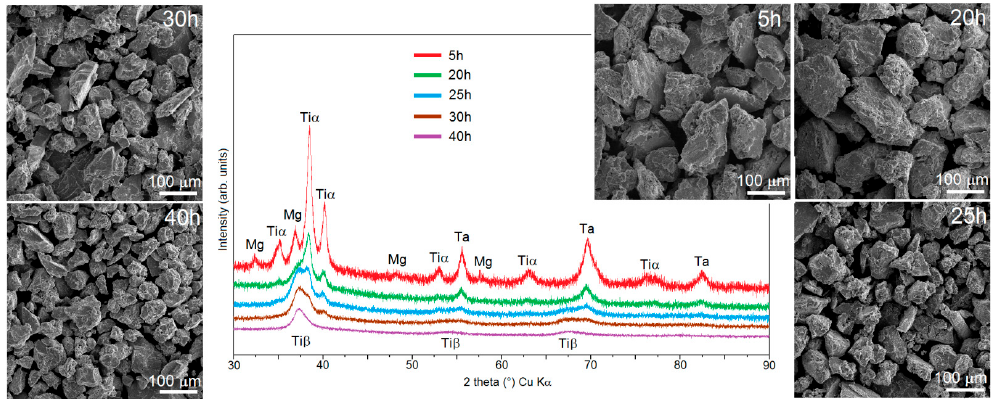
Figure 1. X-ray powder diffraction (XRD) spectra of the Ti-30Ta-30Mg and scanning electron microscope (SEM) micrographs of the powders at different milling times.